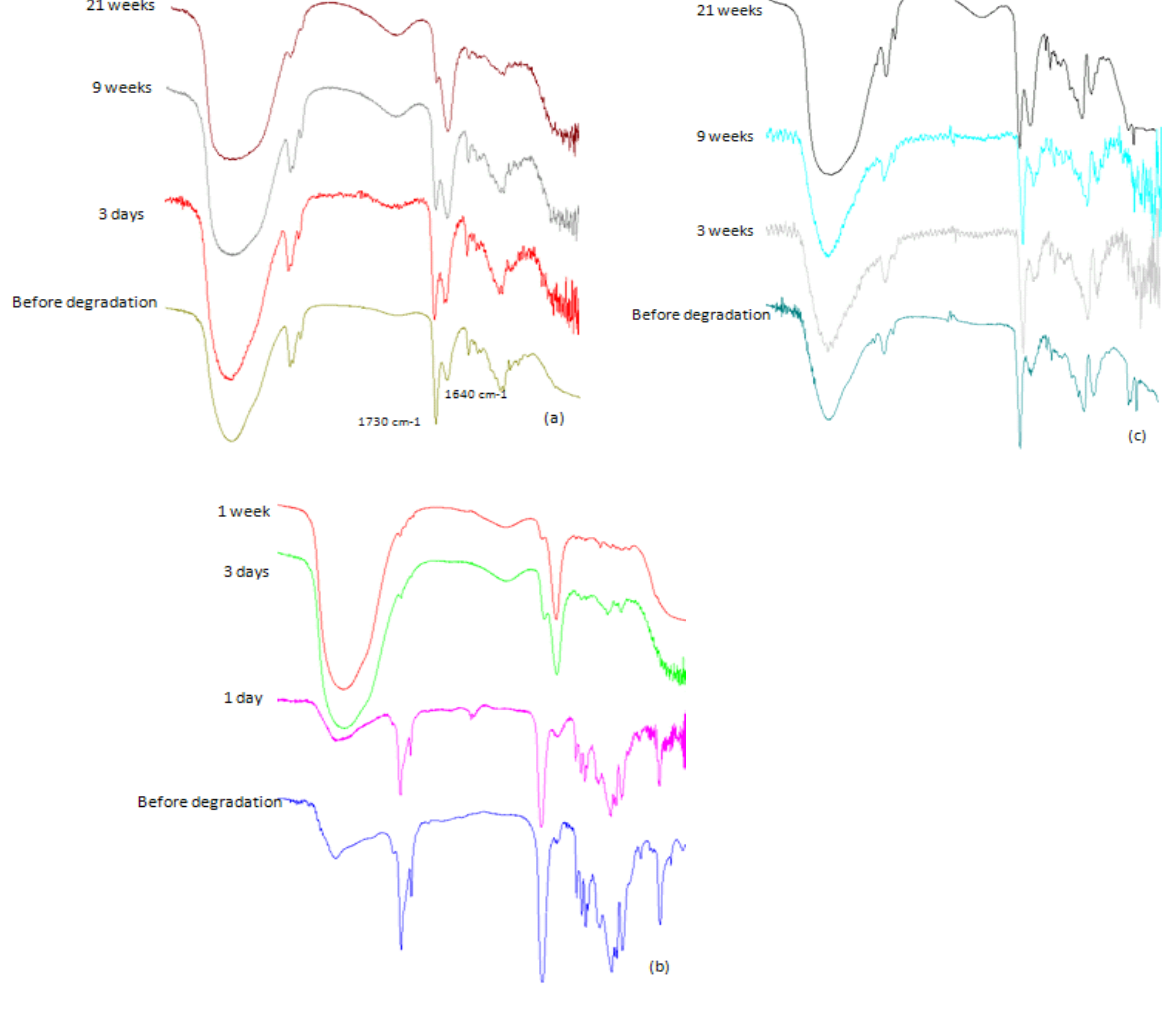
Figure 5. IR spectra of some polymers at several time points during